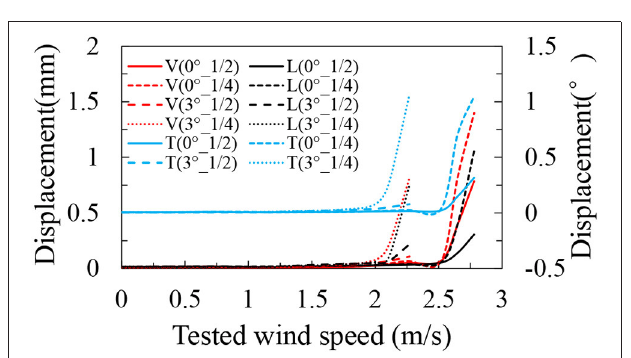
FIGURE 23 | RMS of displacements under uniform flow.